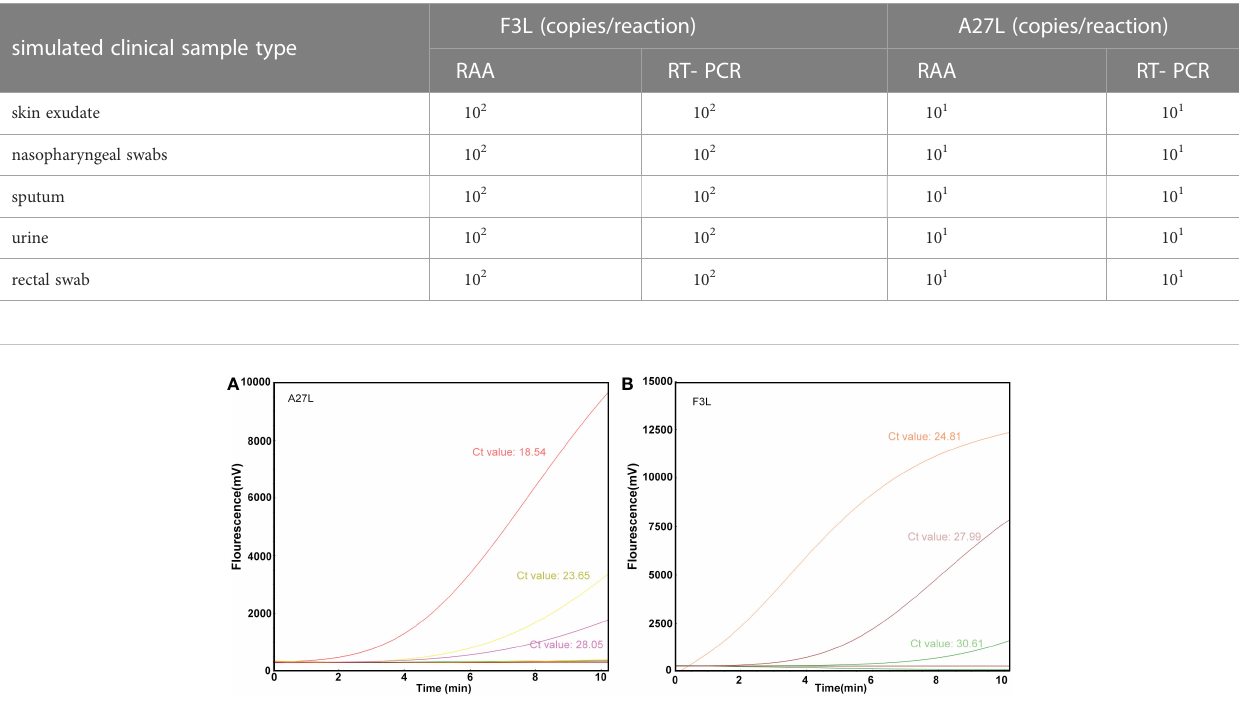
FIGURE 4 Detection ef fi cacy of the RAA assay in clinical samples. The clinical blinded samples were detected using RAA and RT-PCR assays at the same time, and the results of A27L (A) and F3L (B) were shown respectively, and the values next to the curves were results of RT-PCR assay.